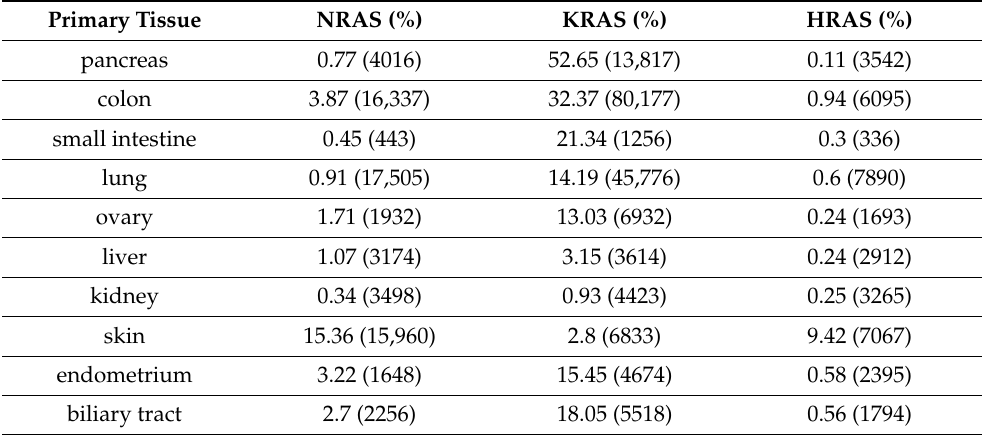
Table 2. Frequency of RAS isoform mutations in human cancer. Table shows the distribution of mutations in the various primary tissue types. Data are from the COSMIC database. Numbers in parentheses indicate sequence of total tested